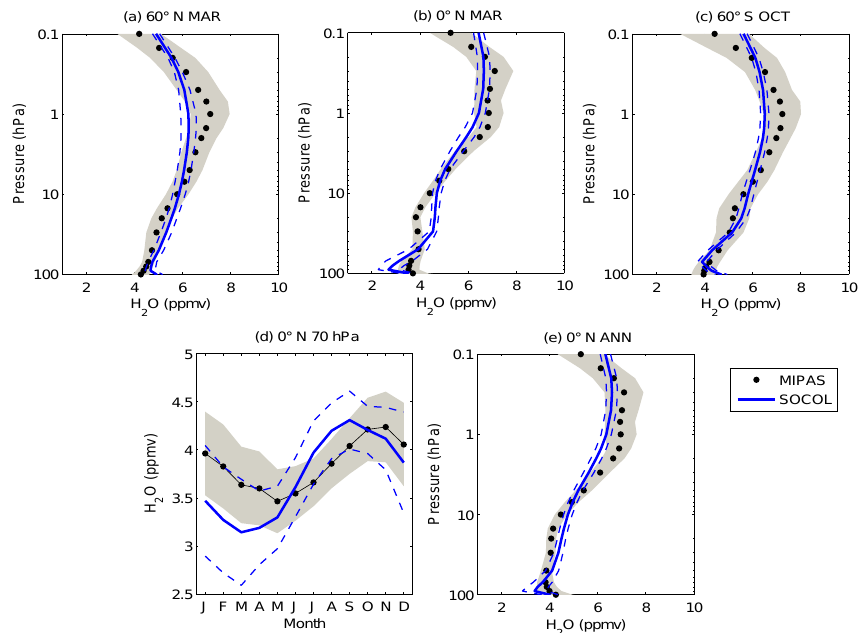
Figure 2. Modelled water vapour from the SOCOL v.3 RCP 6.0 simulation compared with MIPAS observations (climatological means for 2005–2012) for (a) 60 ◦ N, March; (b) the Equator, March; (c) 60 ◦ S, October; (d) the Equator, 70hPa; and (e) the Equator, annual mean. The grey shaded areas represent 1 standard deviation either side of observations and the dashed blue lines represent 1 standard deviation either side of model data.